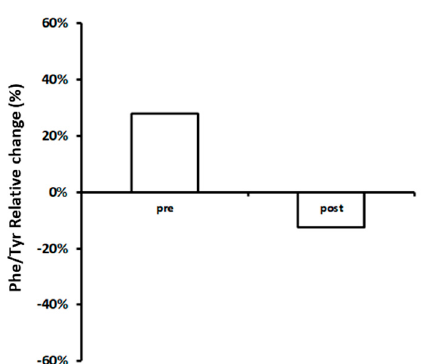
Figure 4. Relative differences of HIV negative individuals from normal level of phenylalanine/tyrosine ratio (Phe/Tyr) calculated before and after supplementation of probiotics. Average (grey: untreated; white: treated).